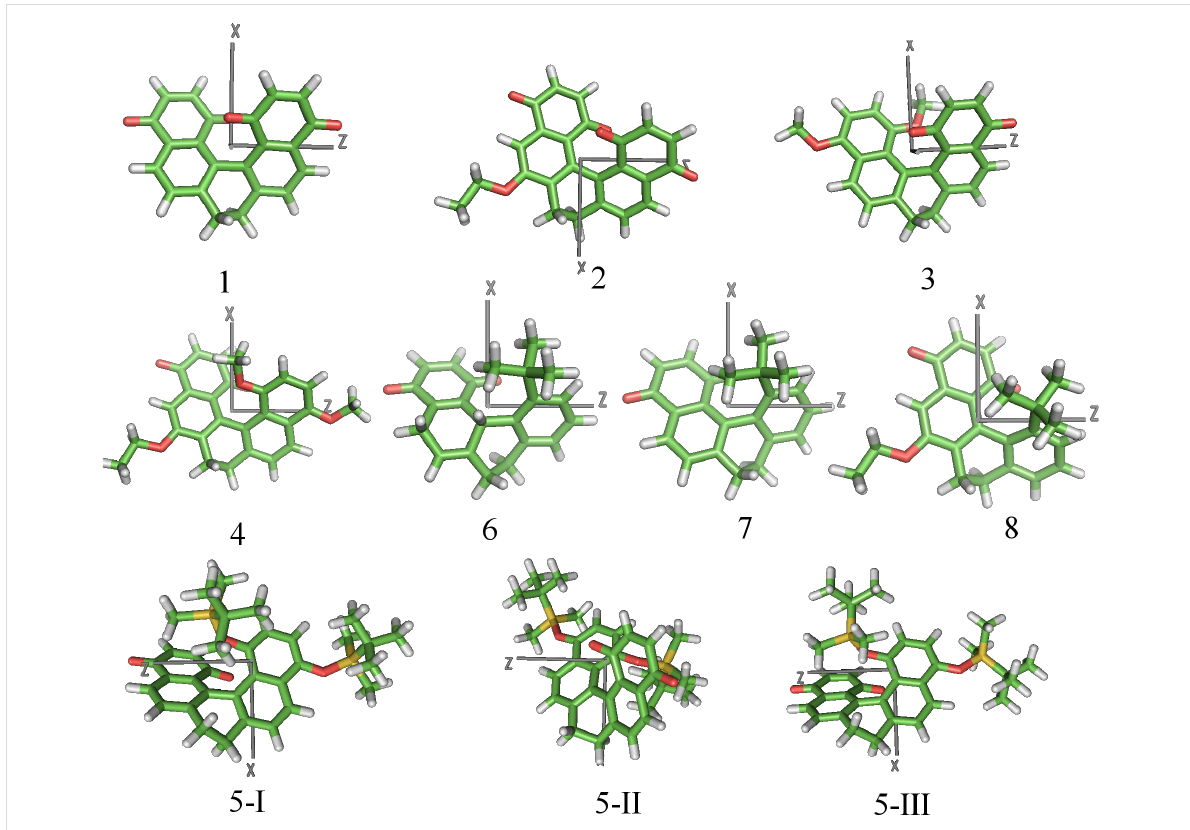
Figure 3: Geometry of dopants 1–8 . Structures were obtained from DFT calculations at the B3LYP/6-31g** level [58]. The xz plane is perpendicular to the molecular axis ( y ) with the lowest propensity to align to the local director, and z is the axis with the highest tendency to lie parallel to the